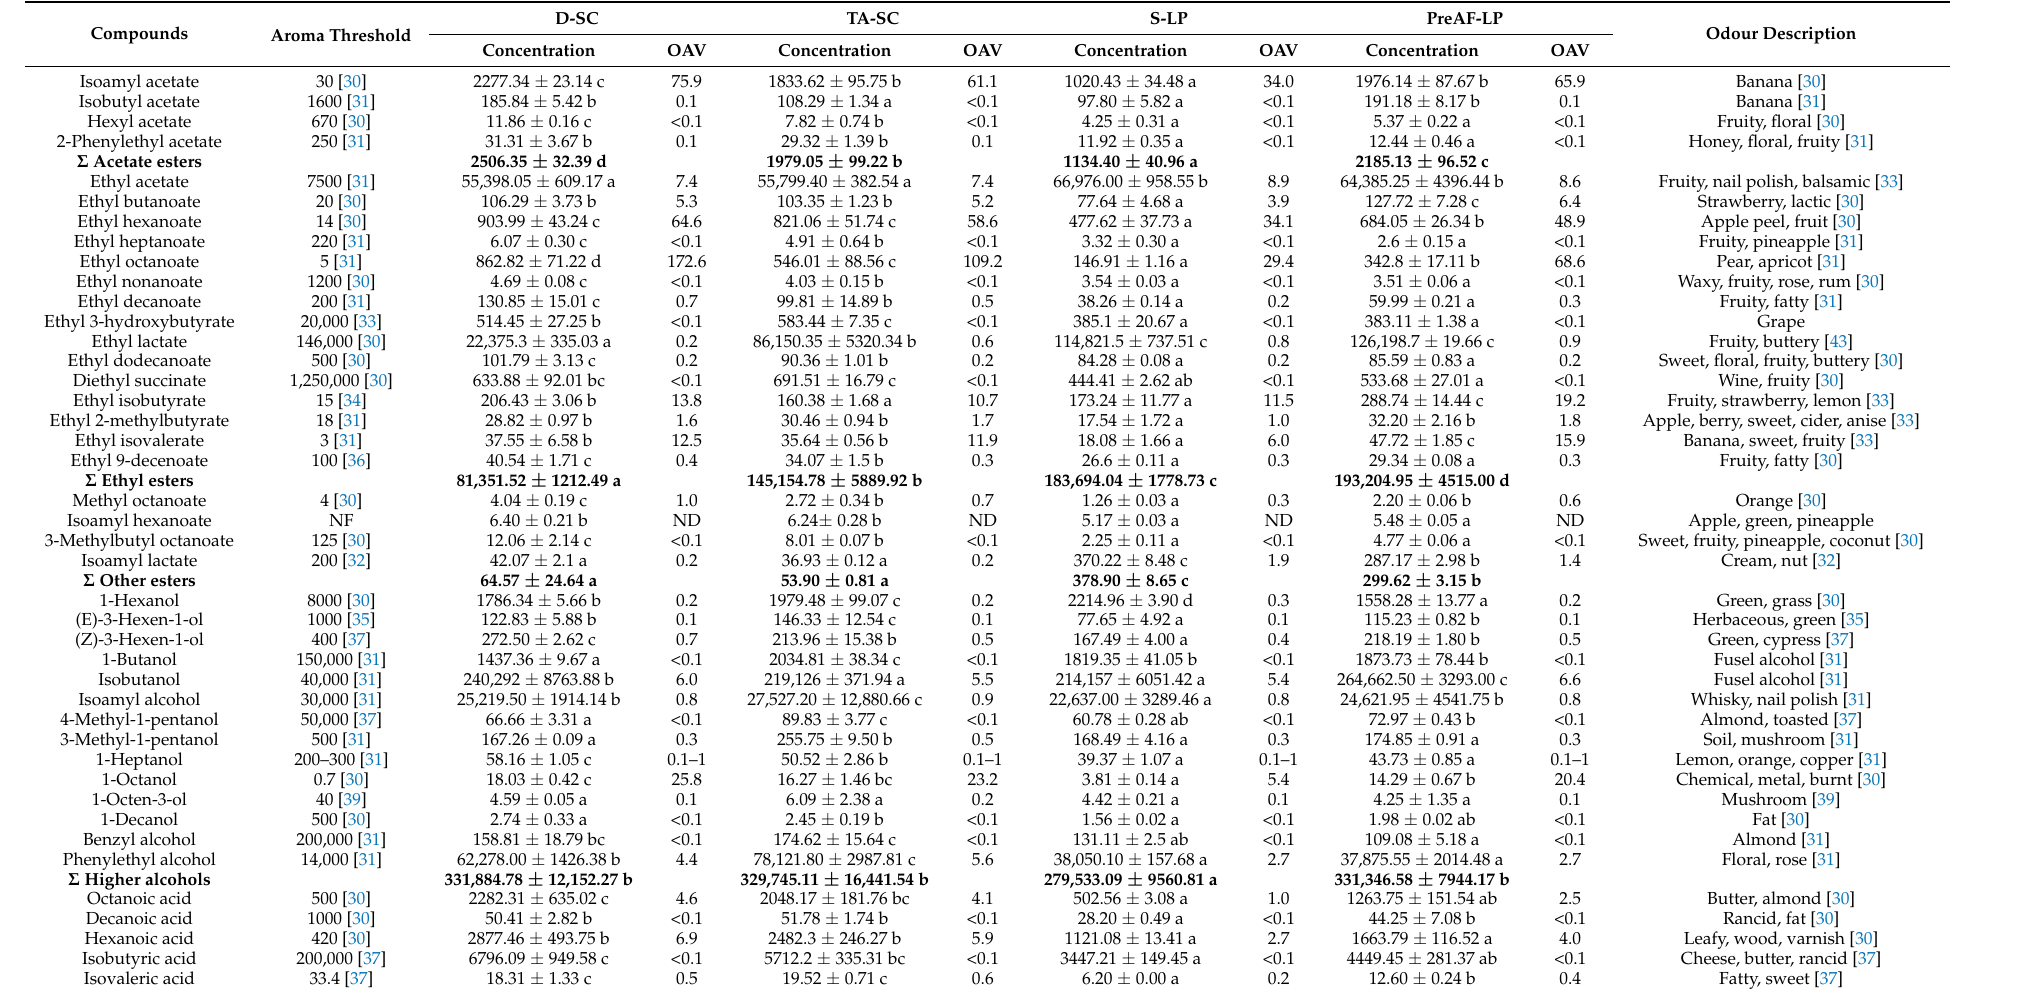
Odour Description